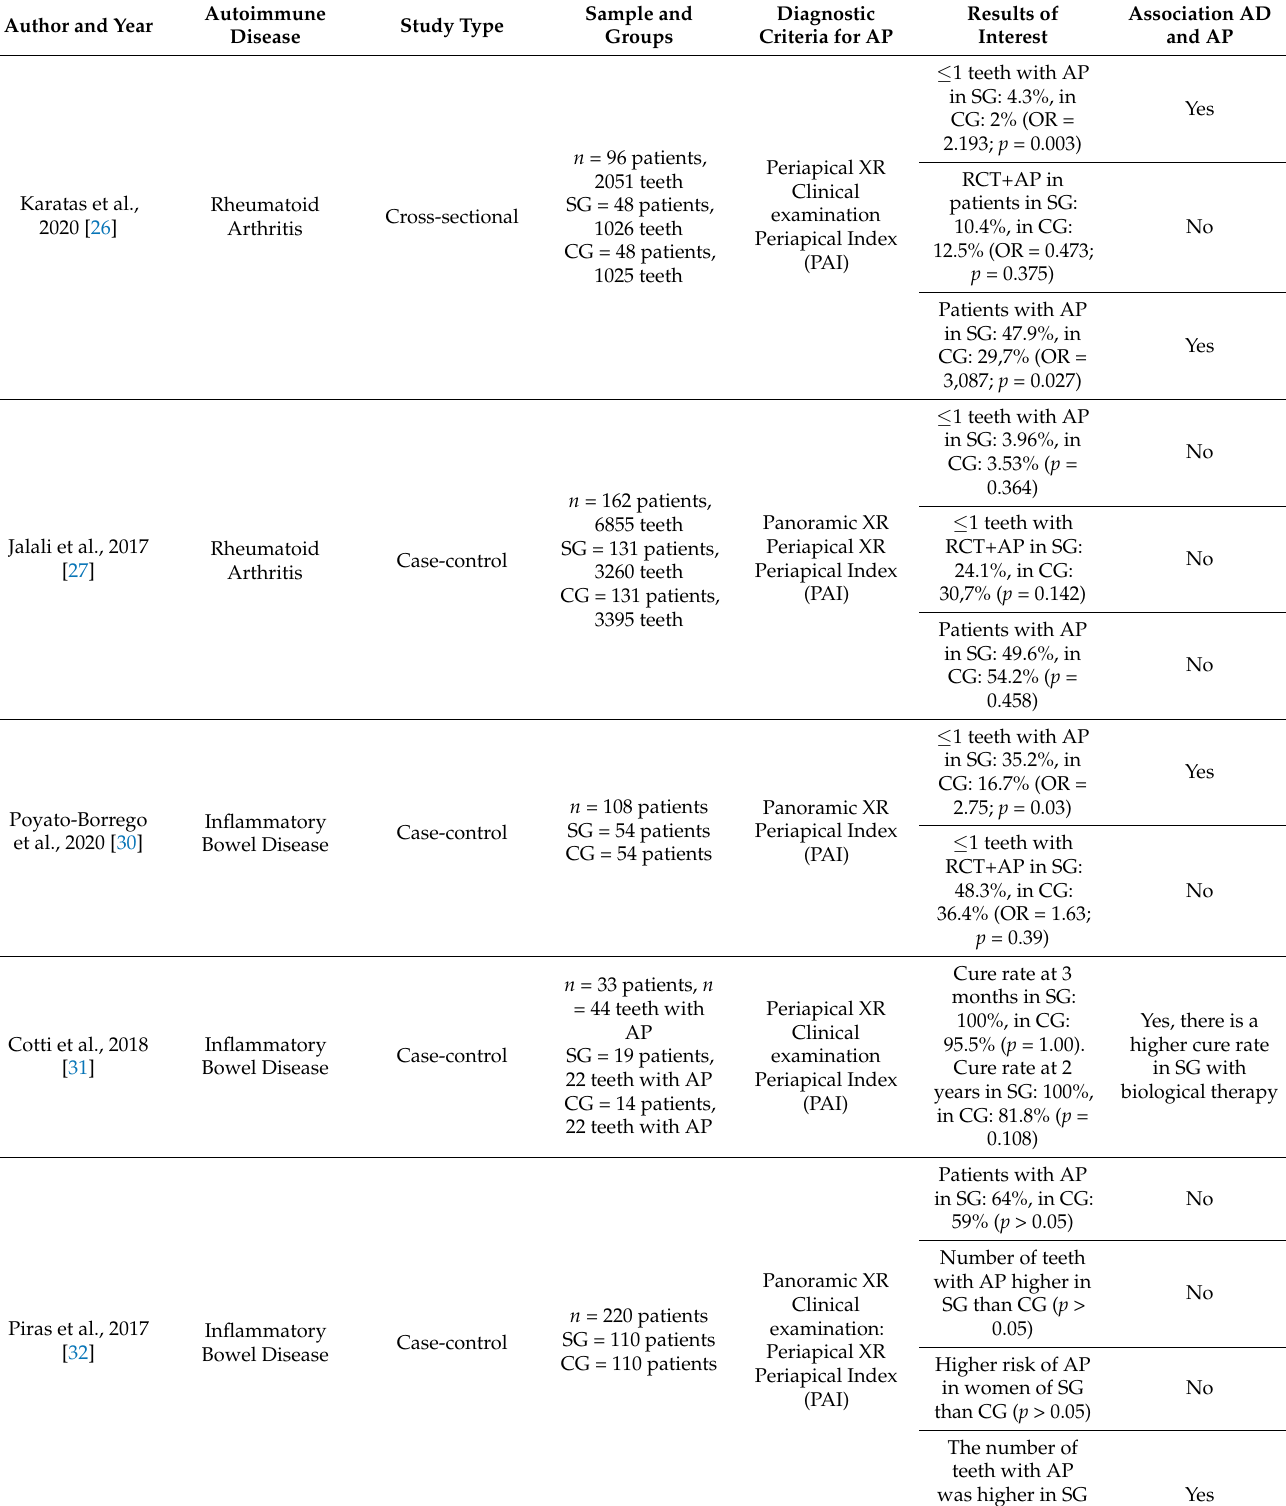
Table 4. Summary of main results of included